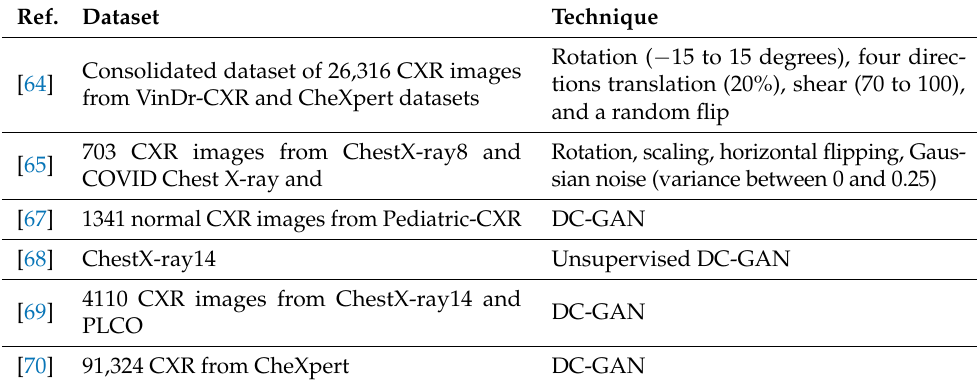
Table 3. Overview of different data-augmentation techniques for CXR images. Ref.